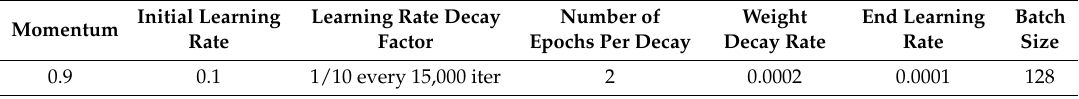
Table 4 . Hyperparameters used in training the ResNet network. Table 4. Hyperparameters used in training the ResNet